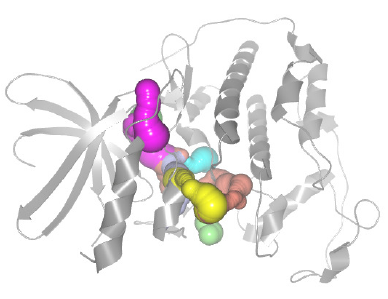
Figure 1. The CDK2 crystal structure and its cavity are calculated by CAVER Analyst 2.0 and visualized using software PyMOL. The protein molecule is shown as a gray cartoon representation. Each cavity is distinguished by